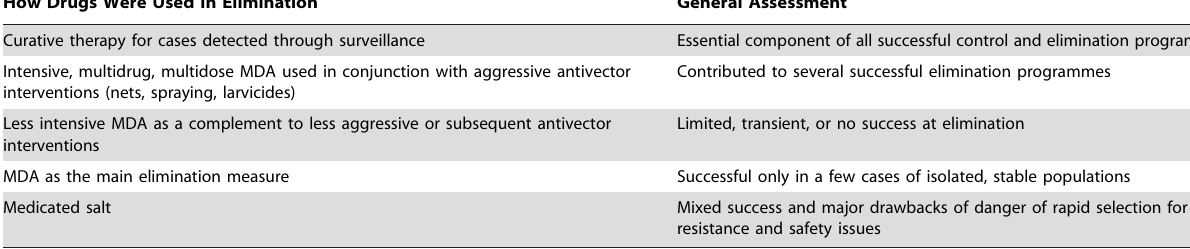
Table 2. Past use of drugs in malaria